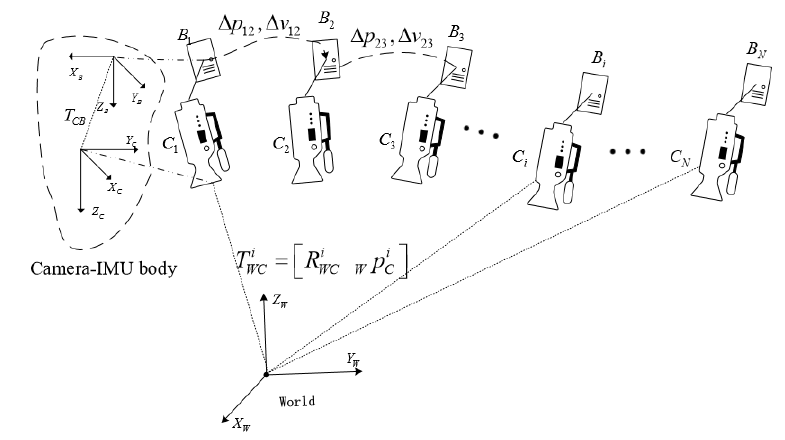
Figure 1. The relationship between different coordinate frames and multiple states of